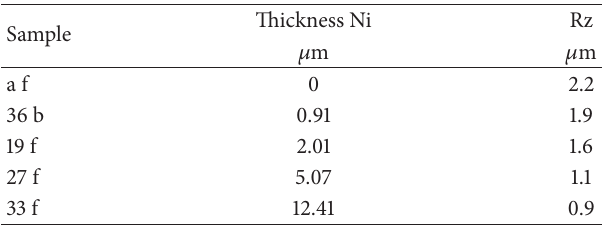
Table 2: Surface roughness of some significant samples. Rz average value of the five adjacent maximum heights of